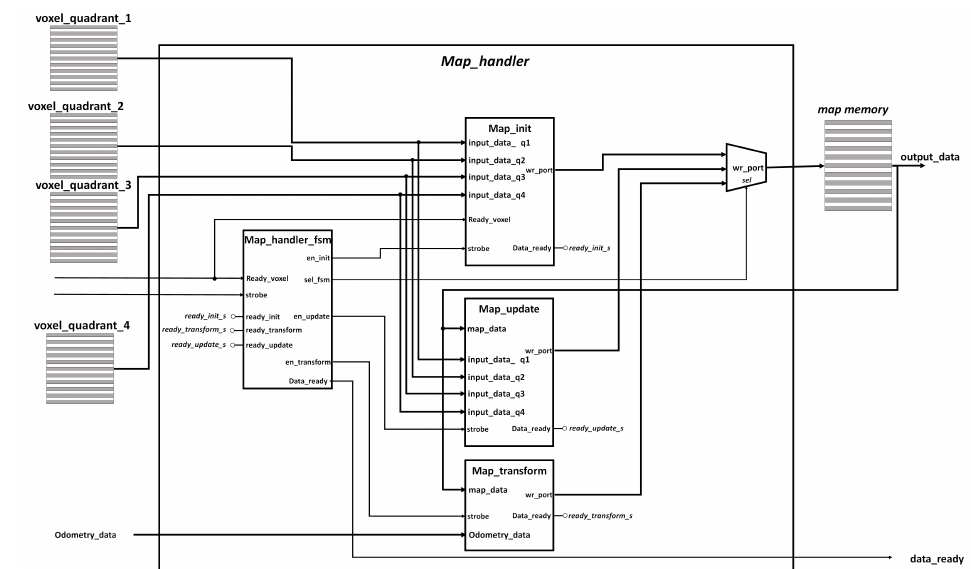
Figure 9. Map_handler internal